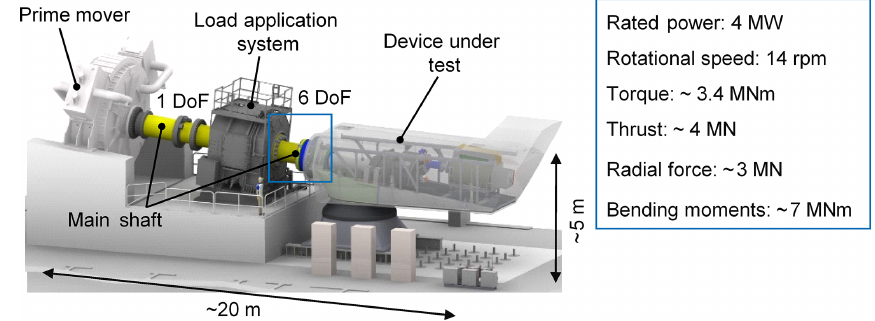
Figure 1. A 4MW RWTH wind turbine test bench (Averous et al., 2015), showing the main